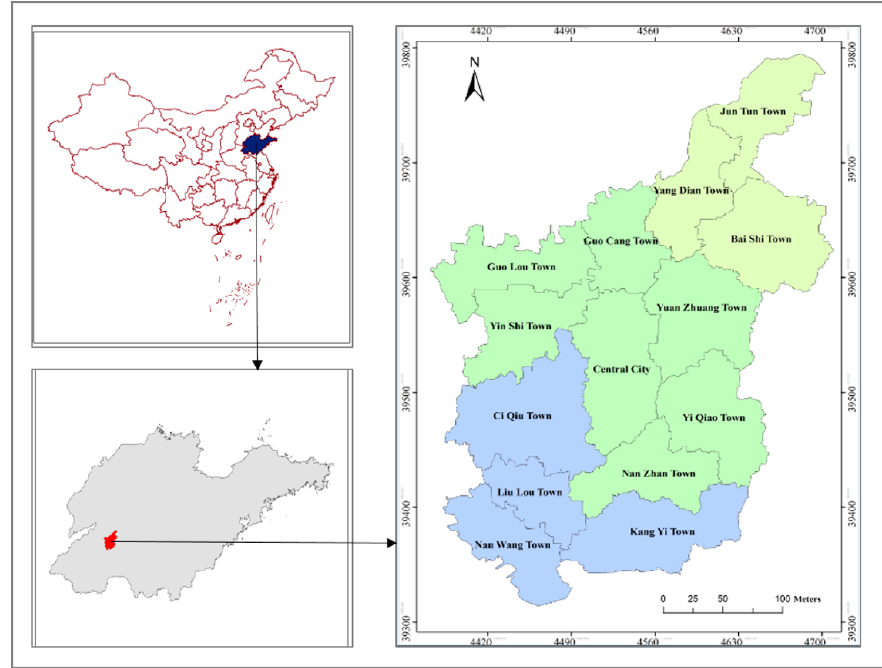
Figure 3. Location map of Wenshang County.